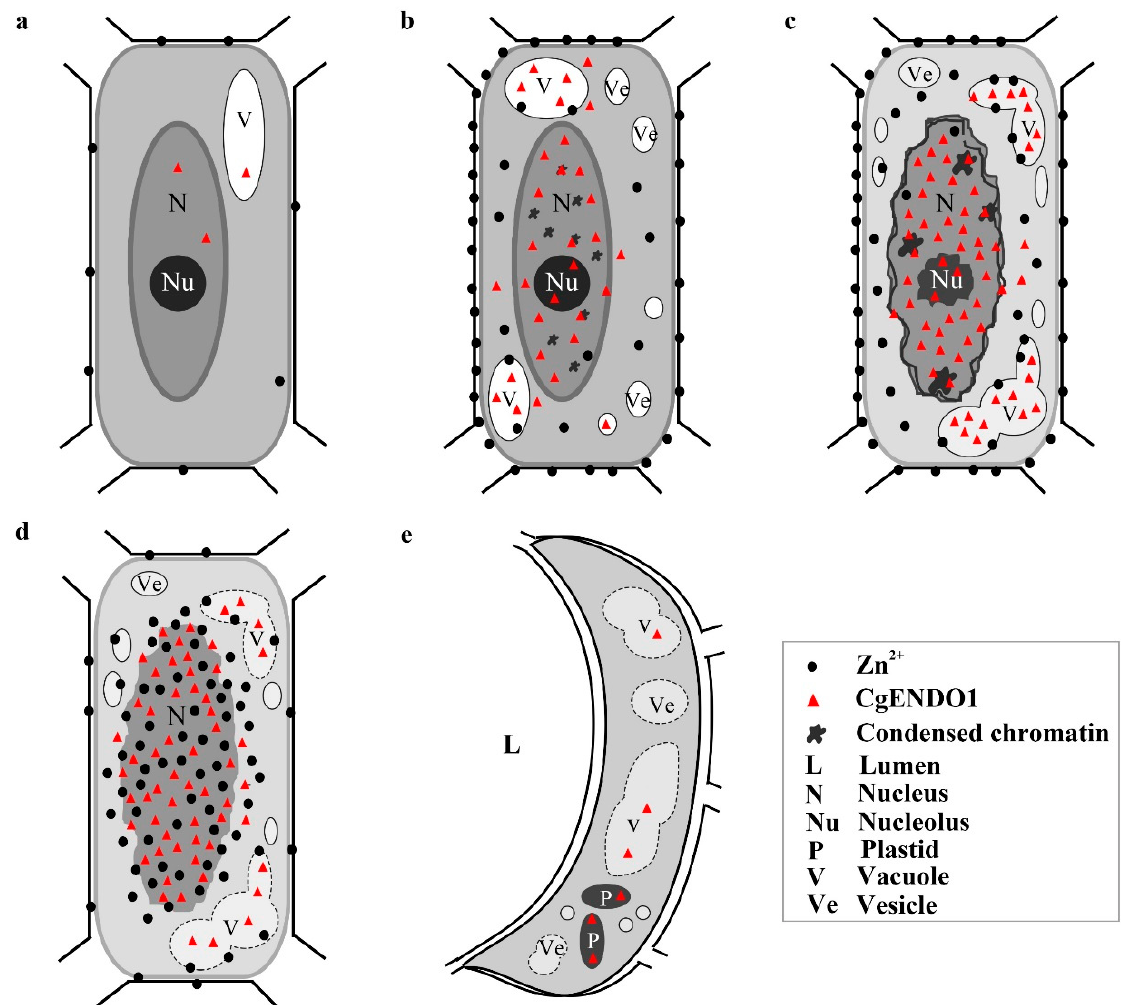
Figure 7. The pattern of Zn 2+ ‐ ions and Zn 2+ ‐ dependent nuclease 1 (CgENDO1) involved in PCD in the development of the secretory cavity of Citrus grandis ‘Tomentosa’ fruits. In the early initial cell stage ( a ), very little Zn 2+ ions and CgENDO1 are in the cell. In the middle initial cell stage ( b ), a large amount of Zn 2+ ions is in the cell wall and a large amount of CgENDO1 is in the nucleus and vacuole. In the late initial cell stage ( c ), the Zn 2+ ions are transferred into the cytoplasmic matrix and vacuole, while CgENDO1 is heavily concentrated in the nucleus and vacuole. In the lumen ‐ forming stage ( d ), Zn 2+ ions are transferred into the nucleus area, and CgENDO1 is concentrated in the nucleus at the same time, while less CgENDO1 is in the vacuole. In the lumen ‐ expanding stage ( e ), the Zn 2+ ions completely disappear, with only a small amount of CgENDO1 in the vacuole.